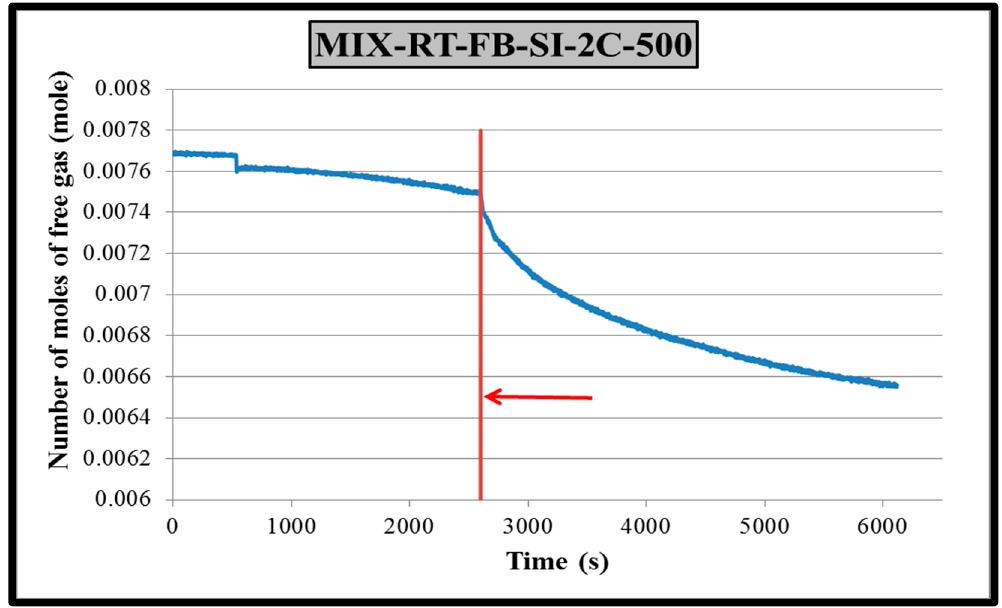
Figure 4. Change in number of moles of free gas in CH4-C3H8-RT-FB-SI-2C experiment. Figure 5 is plotted with the same data as Figure 4 but covering only hydrate formation period.